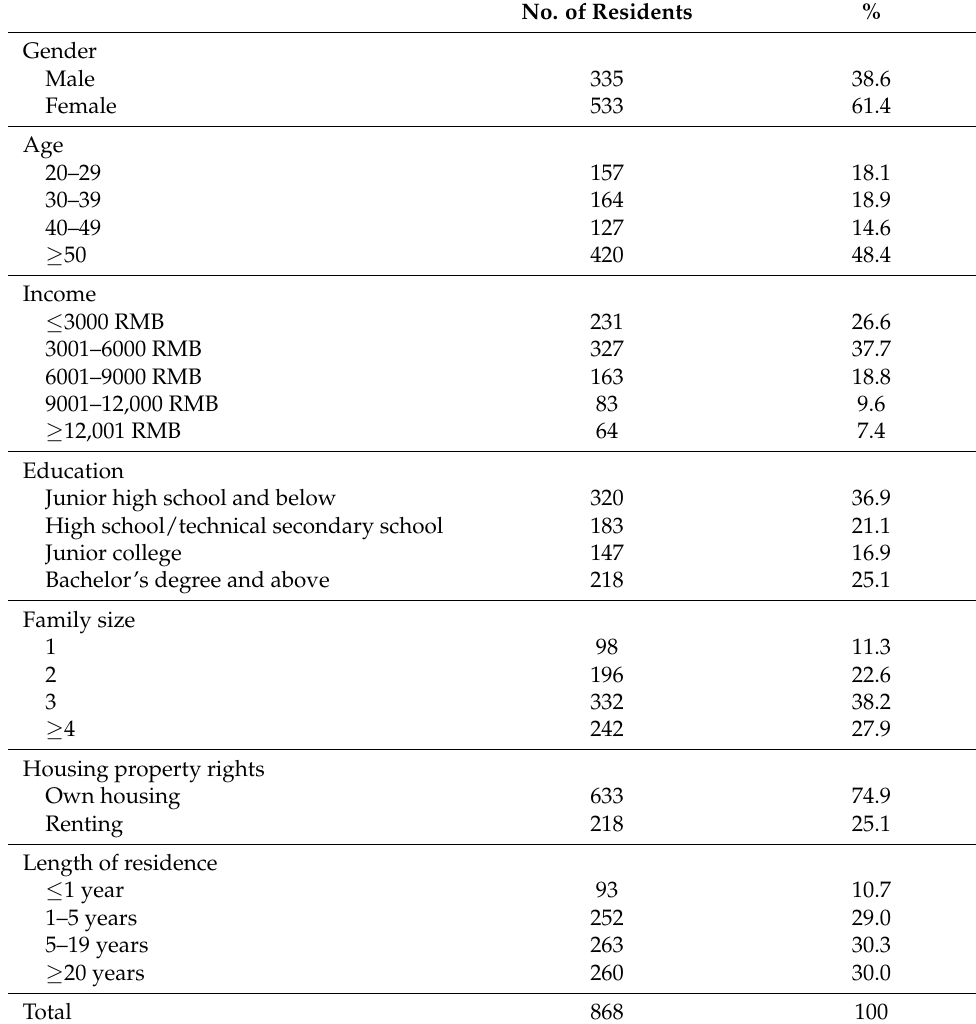
Table 2. Socioeconomic and transitional characteristics of residents in the